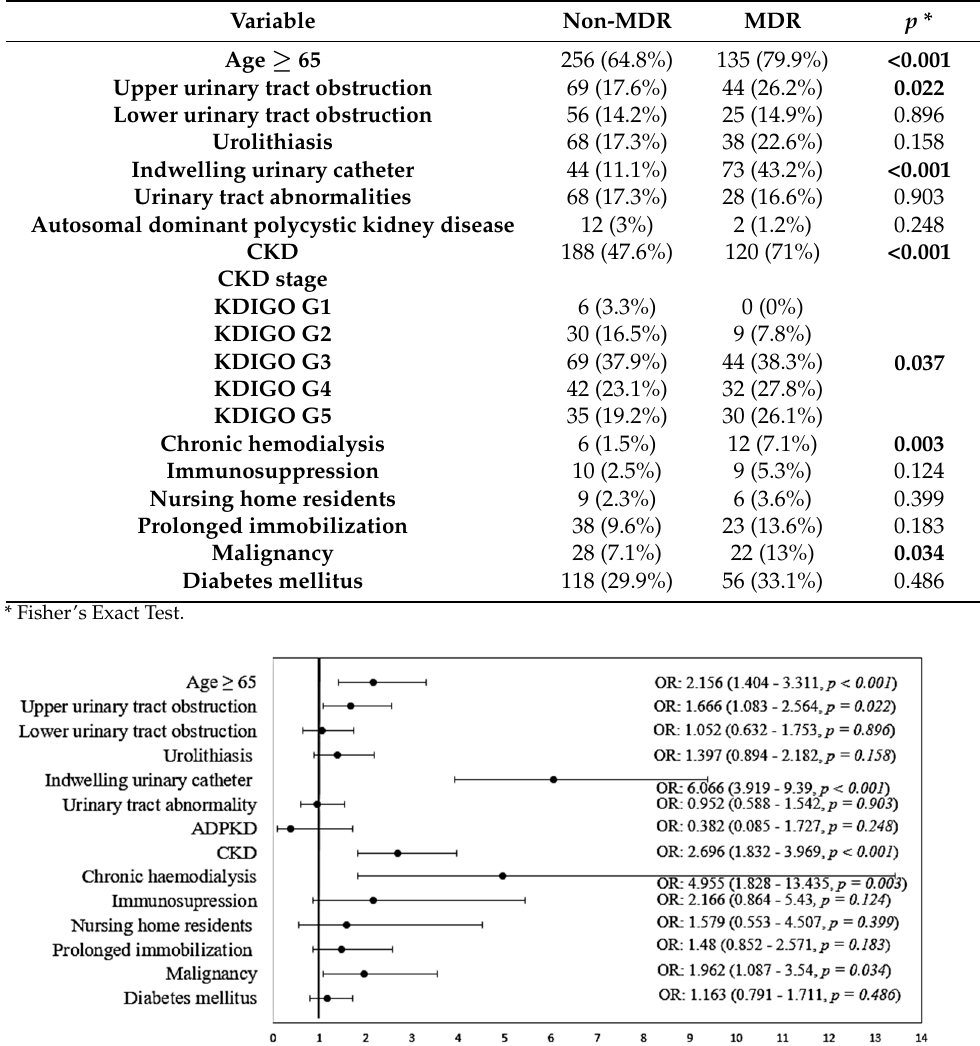
Table 5. Distribution of risk factors related to multi-drug antimicrobial resistance.